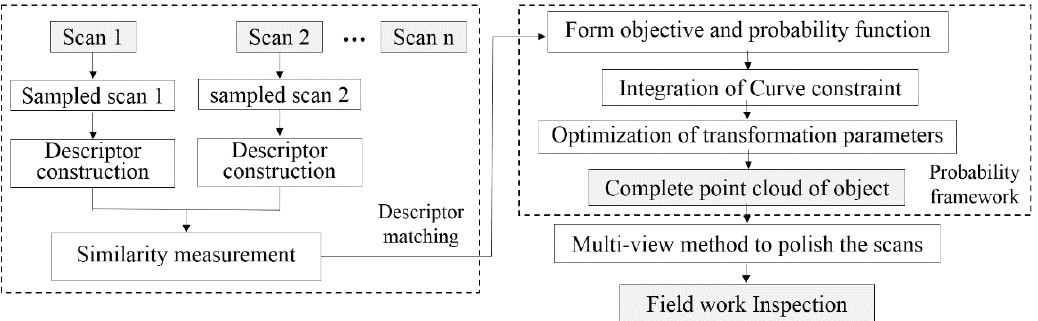
Figure 6. The workflow of the proposed method.